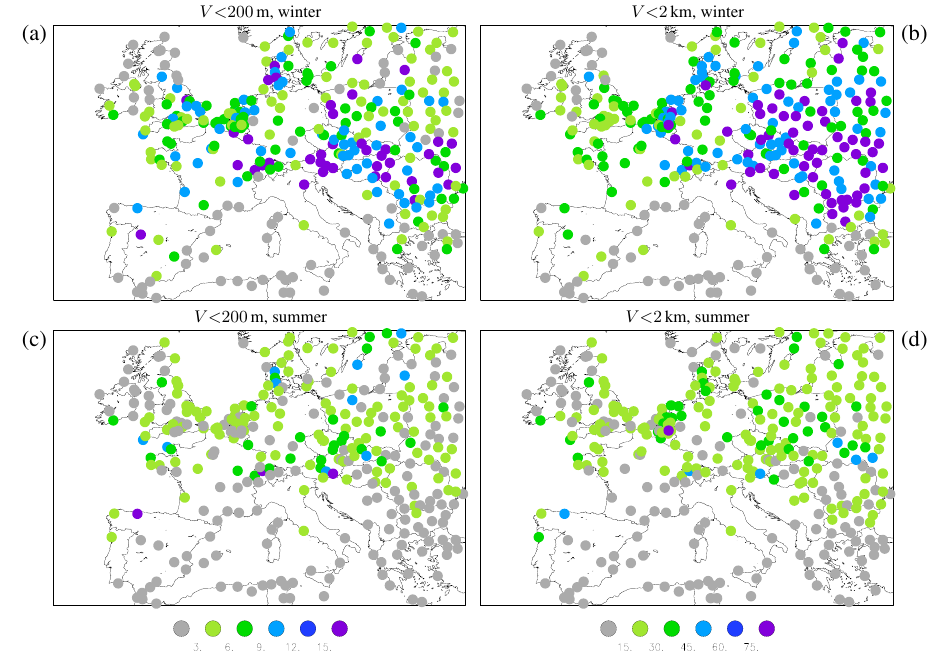
Fig. 1. Mean number of days per half year with low visibility over 1976–2006 in winter (a) and (b) October–March, and summer (c) and (d) April–September. In (a) and (c) the number of days with dense fog (visibility less than 200m) is shown, in (b) and (d) the number of days with visibility less than 2km.